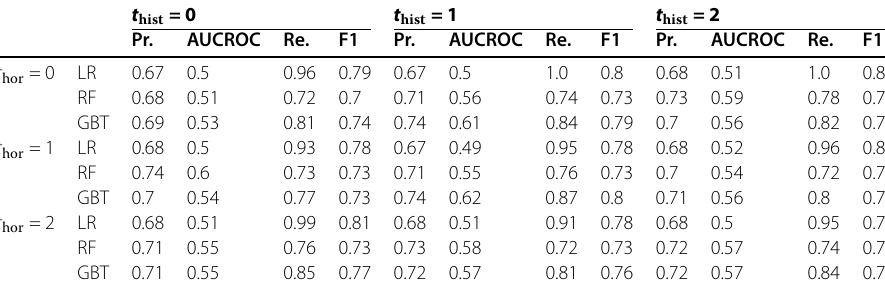
Table 3 Precision (Pr.), Recall (Re.), AUCROC and F1-score of the classifiers obtained with 10-fold-cross-validation and variations of t hor and t hist t hist = 0 t hist = 1 t hist = 2 Pr. AUCROC Re. F1 Pr. AUCROC Re. F1 Pr. AUCROC Re. t hor = 0